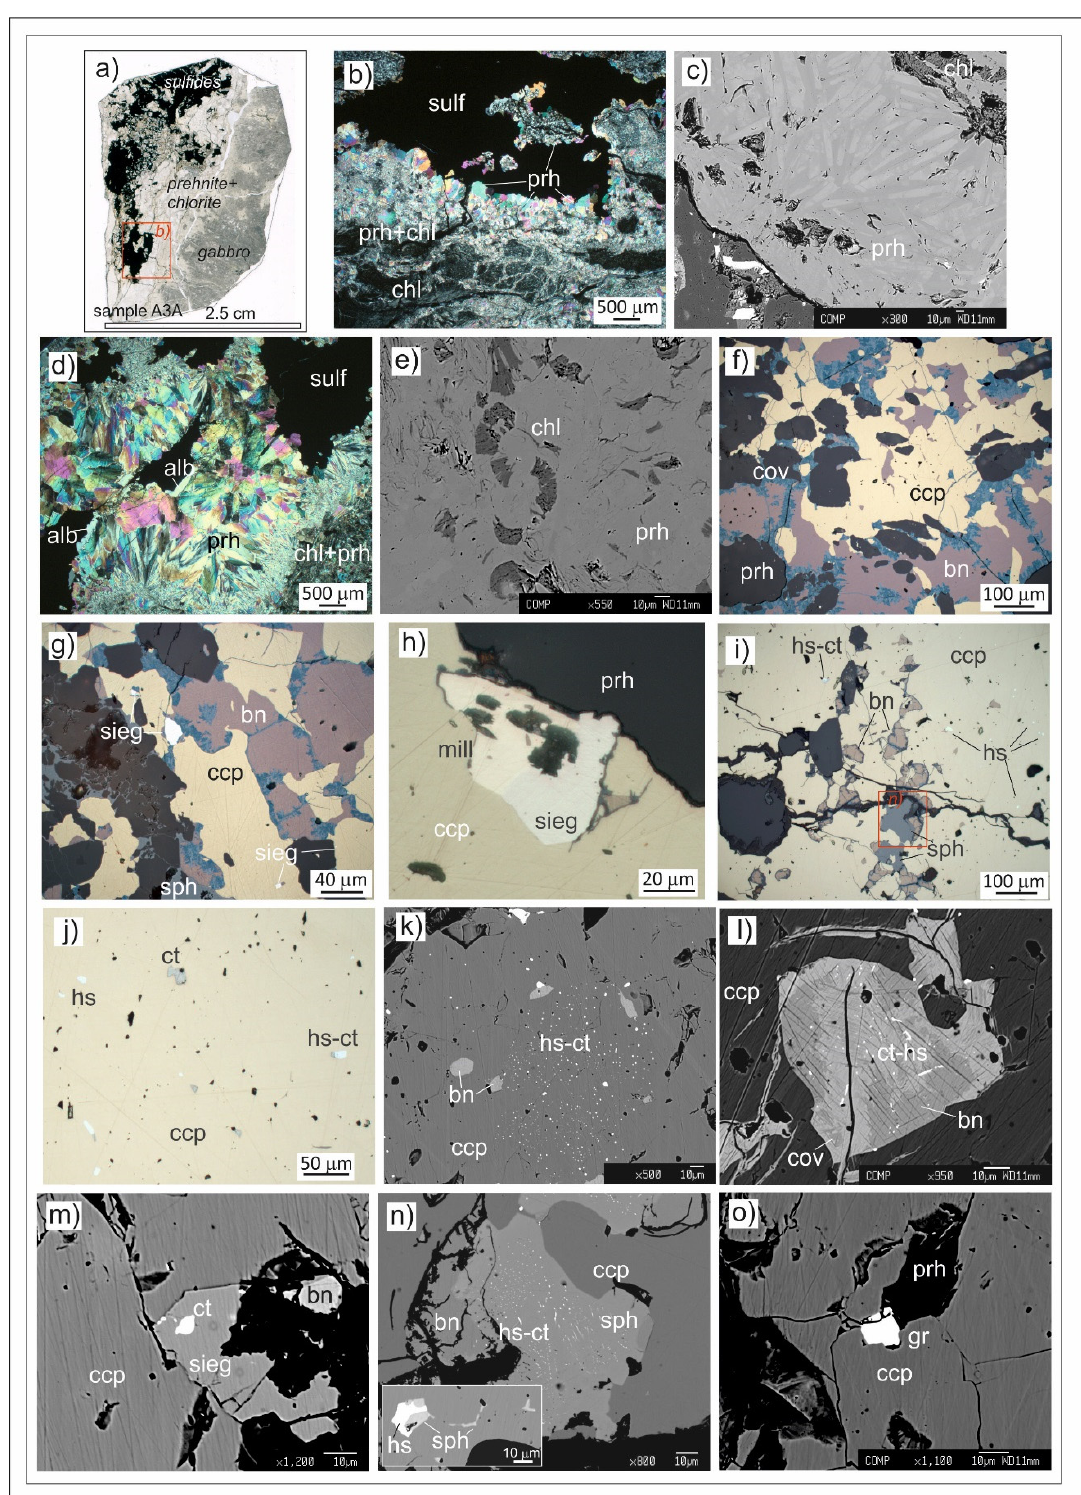
Figure 13. Microscopic features of the mineralization from the Piazza deposit. ( a ) Scan image of a thin section showing the distribution of sulfides (black), ore-related gangue and prehnite–chlorite alteration (pale yellowish grey) in mildly chloritized gabbro (dark grey-greenish): ( b ) Particular of the mineralized veinlet in ( a ) with sulfide aggregate, euhedral prehnite crystals and prehnite–chlorite intergrowths enveloping deeply chloritized fragments of host gabbro. ( c ) Mild Fe zoning in hydrothermal euhedral prehnite. ( d ) Sulfide patch intergrown with euhedral prehnite associated with albite as anhedral rims. ( e ) Intergrowths of fine-grained prehnite (mid grey) and chlorite lamellae (dark grey) in vermicular to booklet-like aggregates. ( f ) Bornite–chalcopyrite aggregate enveloping,